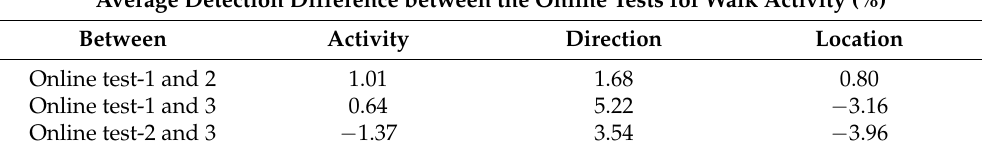
Table 9. Differences between average correct detections in the three online tests for walk activity. Average Detection Difference between the Online Tests for Walk Activity (%) Between Activity Direction Location Online test-1 and 2 1.01